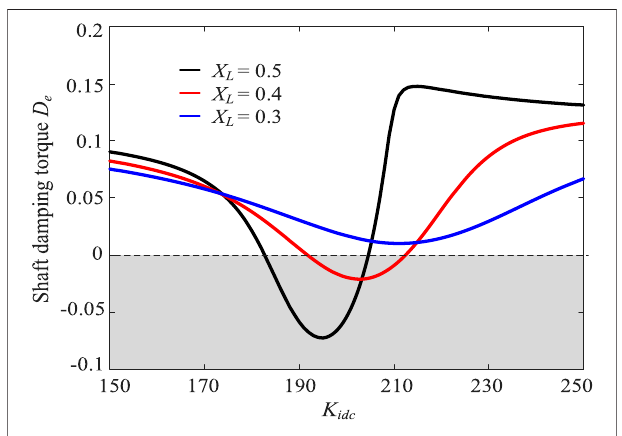
FIGURE 9 | Participation factor of λ 1 for different K idc values ( X L (cid:1) 0.5): (A) K idc (cid:1) 160, (B) K idc (cid:1) 200, (C) K idc (cid:1) 215, and (D) K idc (cid:1) 250.